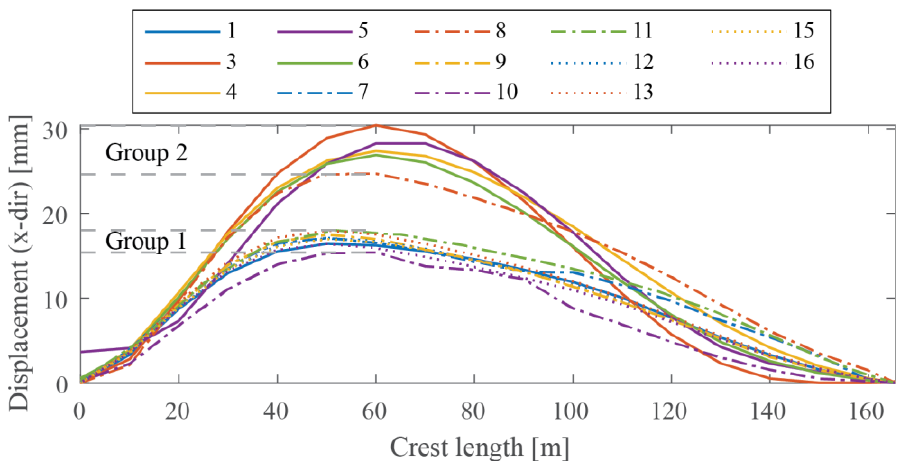
Figure 7. The calculated displacement along the dam crest for static loads based on linear elastic models, according to the contributors.